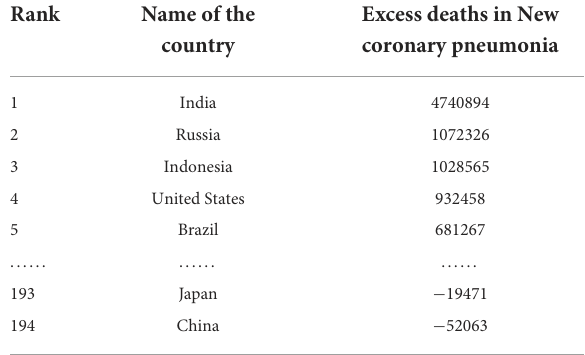
TABLE 2 Global ranking of excess deaths from new coronary pneumonia in 194